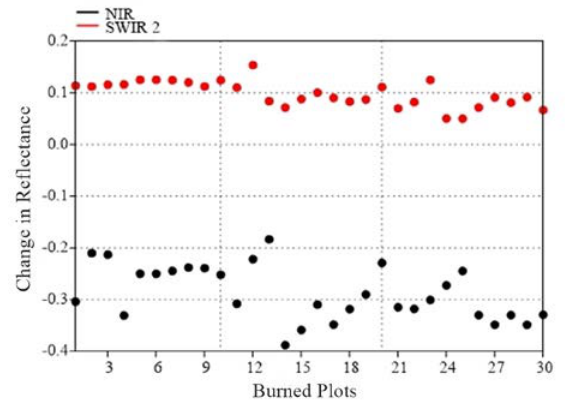
Figure 2. Change in band reflectance of NIR and SWIR between pre-fire and post-fire images of sample burned plots in Tarlac.